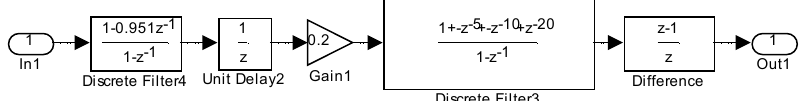
Figure 14. The NTPS algorithm Simulink diagram.